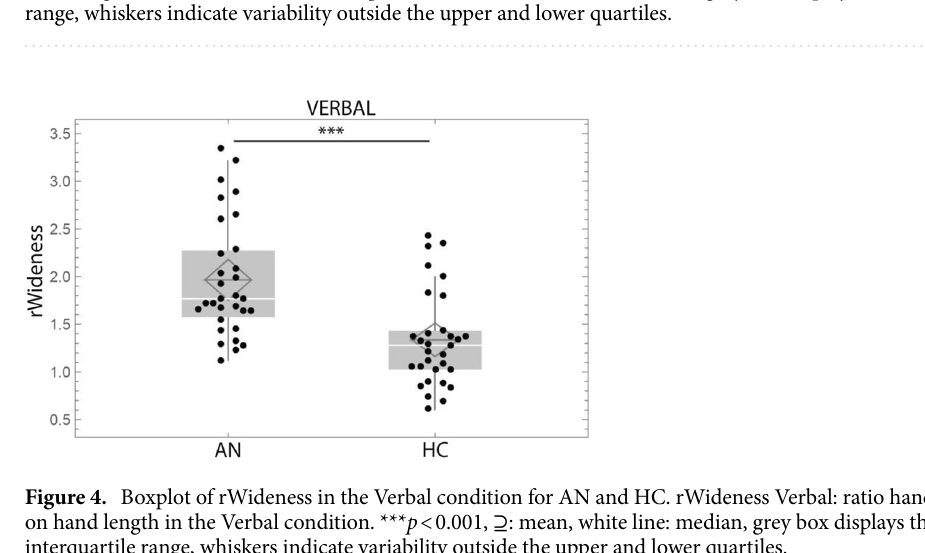
Figure 3. Boxplot of rWideness in the Tactile condition, in AN vs HC. rWideness Tactile: ratio hand width on hand length in the Tactile condition. ** p < 0.01, ⊇ : mean, white line: median, grey box displays the interquartile range, whiskers indicate variability outside the upper and lower quartiles.